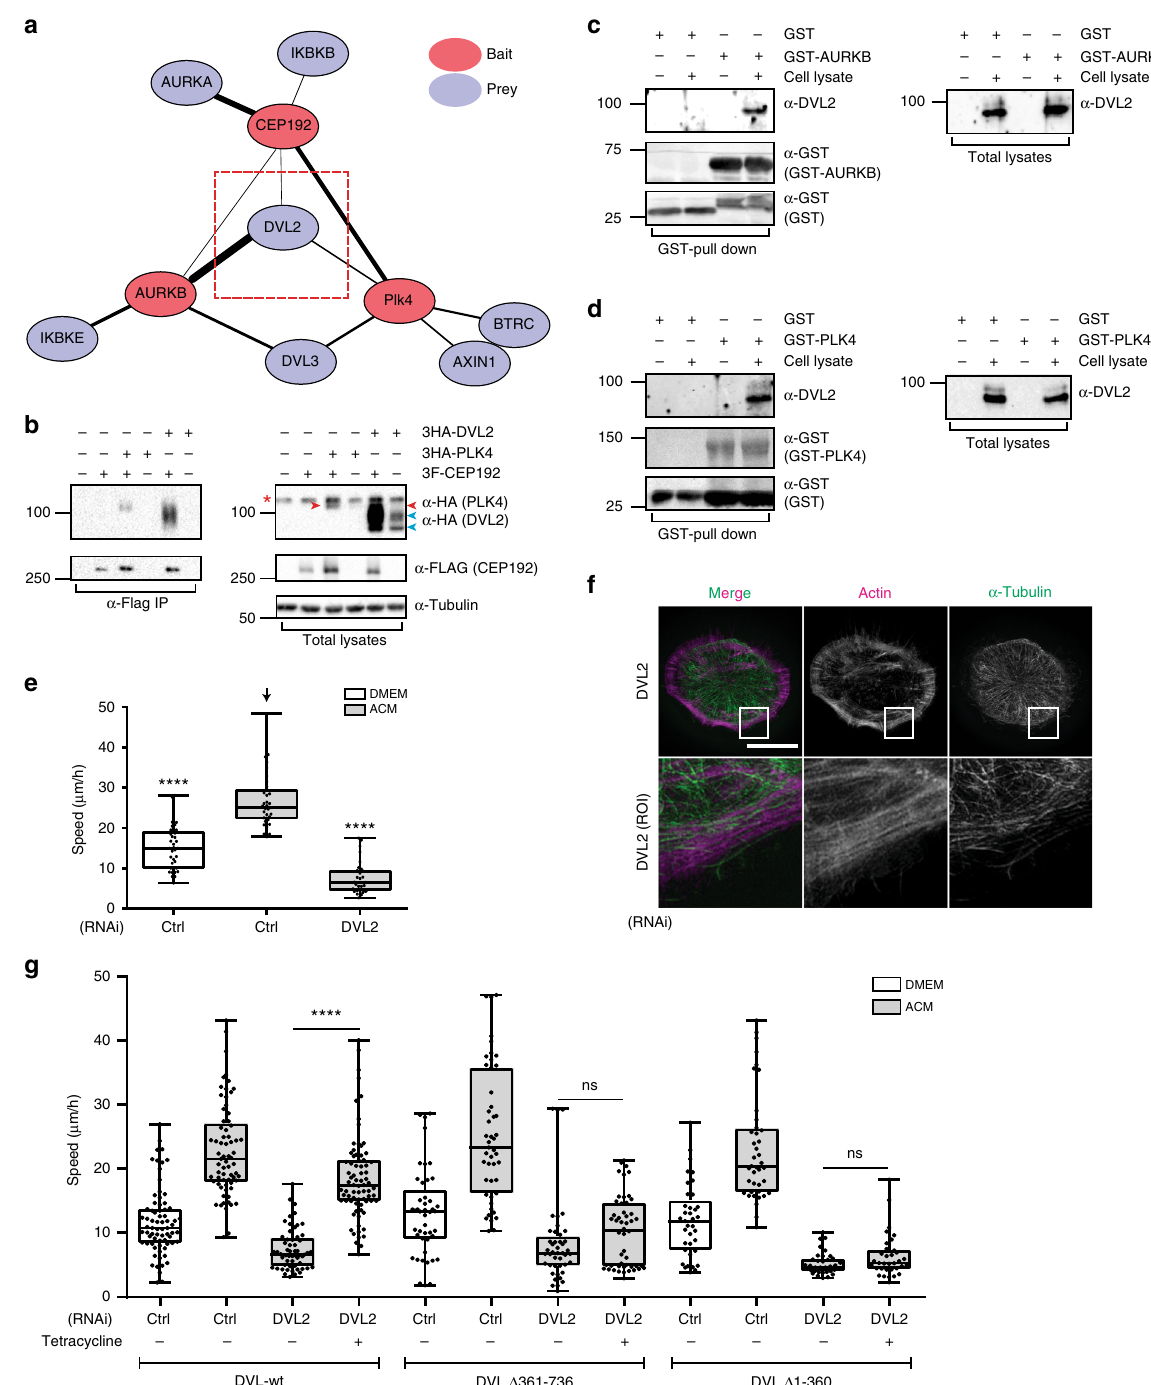
induced accumulation of PLK4pS305 (Fig. 6a, b), PLK4pT170 (Supplementary Fig. 6d, e) and AURKBpT232 at protrusions (Fig. 6c, d). Consistent with their kinase speci fi cities, centrinone inhibited the appearance of PLK4pS305 at the protrusions (Fig. 6a, b), but not AURKBpT232 (Figs. 6c, d, f), while AZD inhibited AURKBpT232 accumulation (Fig. 6c, d), but not PLK4pS305 (Fig. 6a, b, e). Knockdown of PLK4 (Fig. 7a, b), or AURKB (Fig. 7c, d), con fi rmed the speci fi city of these antibodies and showed that PLK4 and AURKB are independently recruited to the cortex. Moreover, downregulation of either CEP192 or DVL2 inhibited recruitment of PLK4pS305 (Fig. 7a, b)